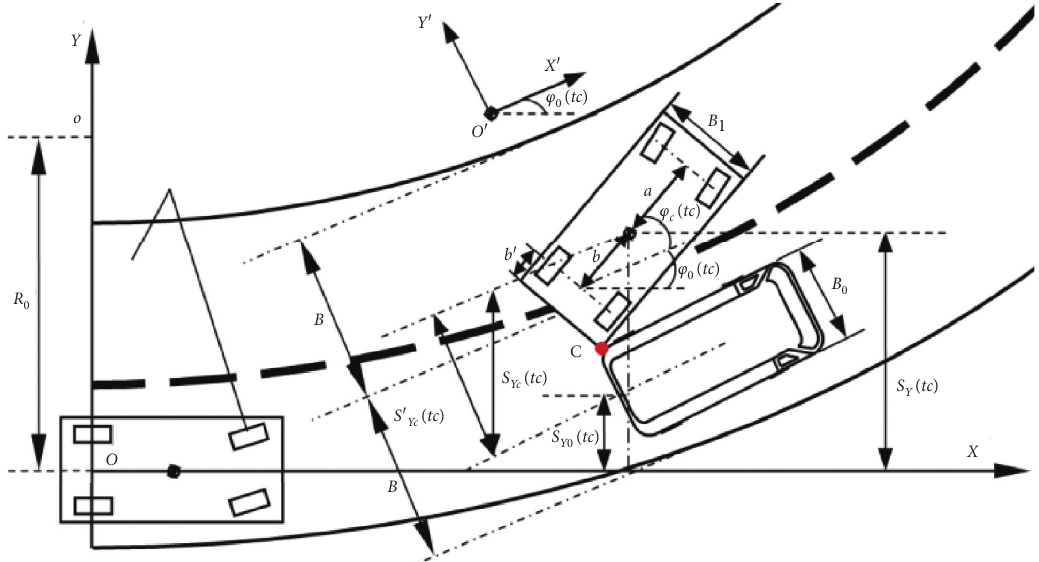
Figure 4: Critical position relationship for safe lane